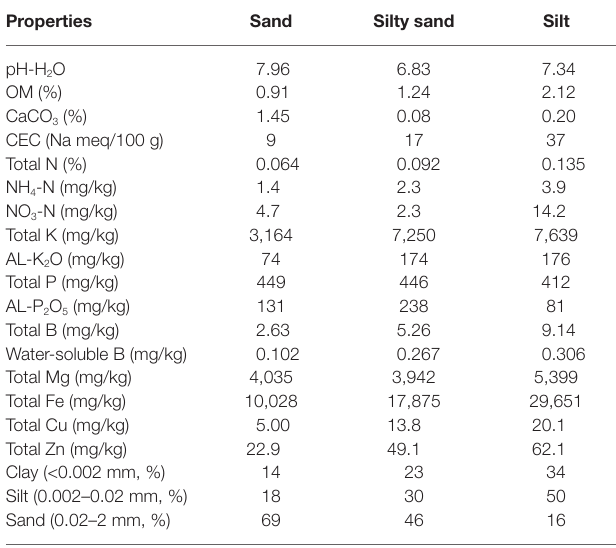
TABLE 1 | Selected properties of the applied